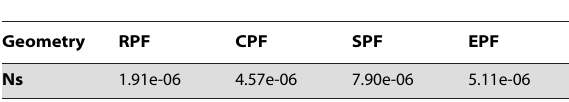
ffiffiffiffiffiffiffiffiffiffiffiffiffiffiffiffiffiffiffiffi C p(cid:5) 6 Nu ‘ k eq ‘